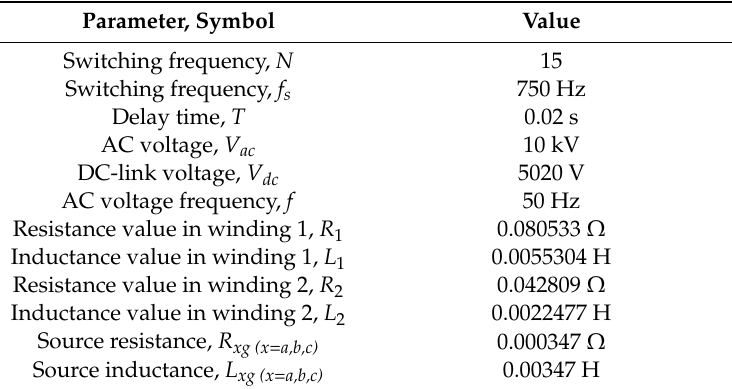
Figure 6. Simulation model based on the proposed HPWM algorithm.